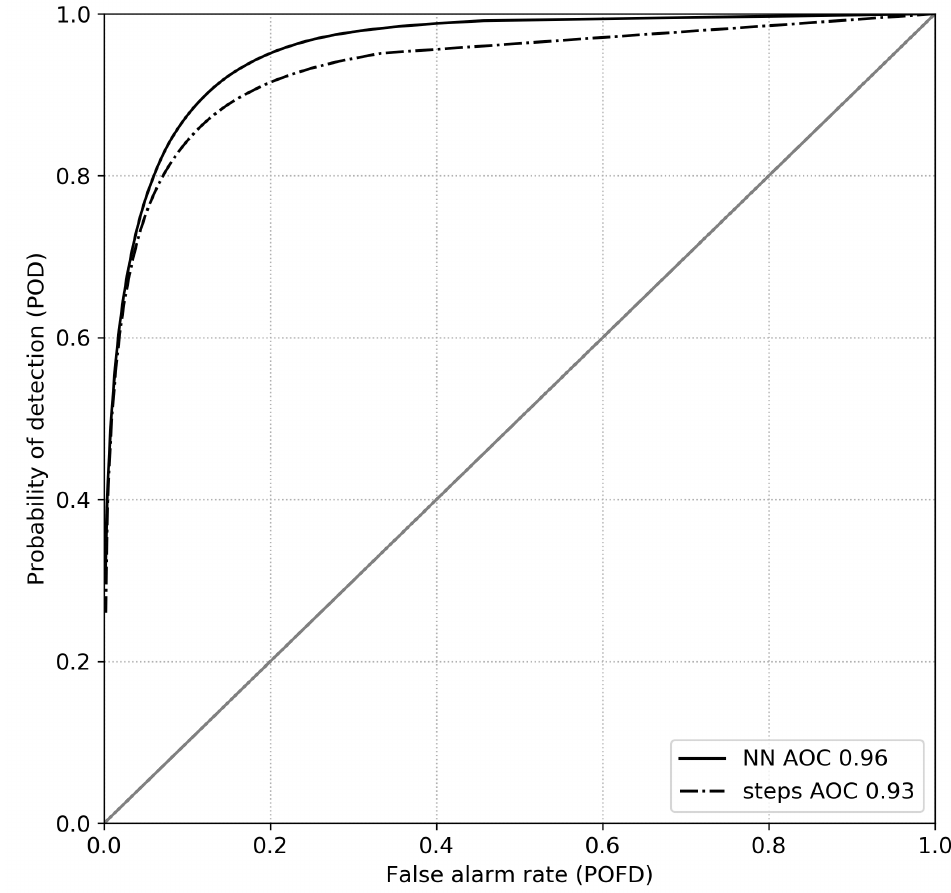
Figure 13. ROC curve for NN and STEPS for exceeding the cumulative precipitation threshold of 1 mm/hr in the first hour of nowcast.